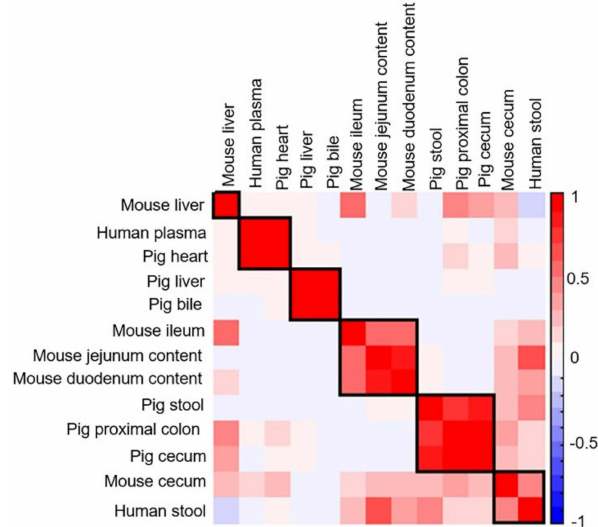
Figure 10. Correlation matrix of analyzed biological samples in the positive ionization mode. Values and shading intensities represent Pearson rank correlation coefficients.